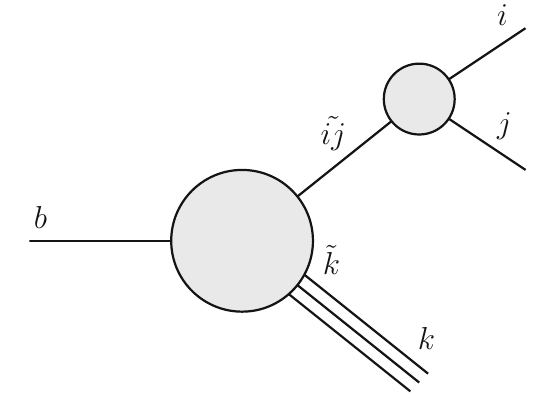
Fig. 3 The final–initial decay